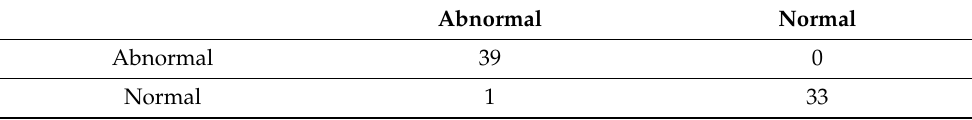
Table 5. Confusion matrix for the Figshare dataset using the BTR